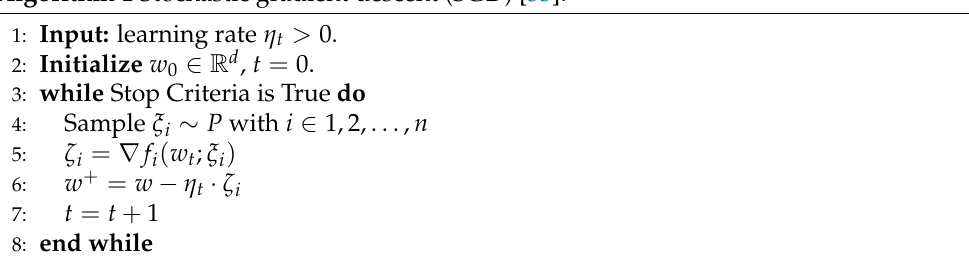
Algorithm 1 Stochastic gradient descent (SGD)